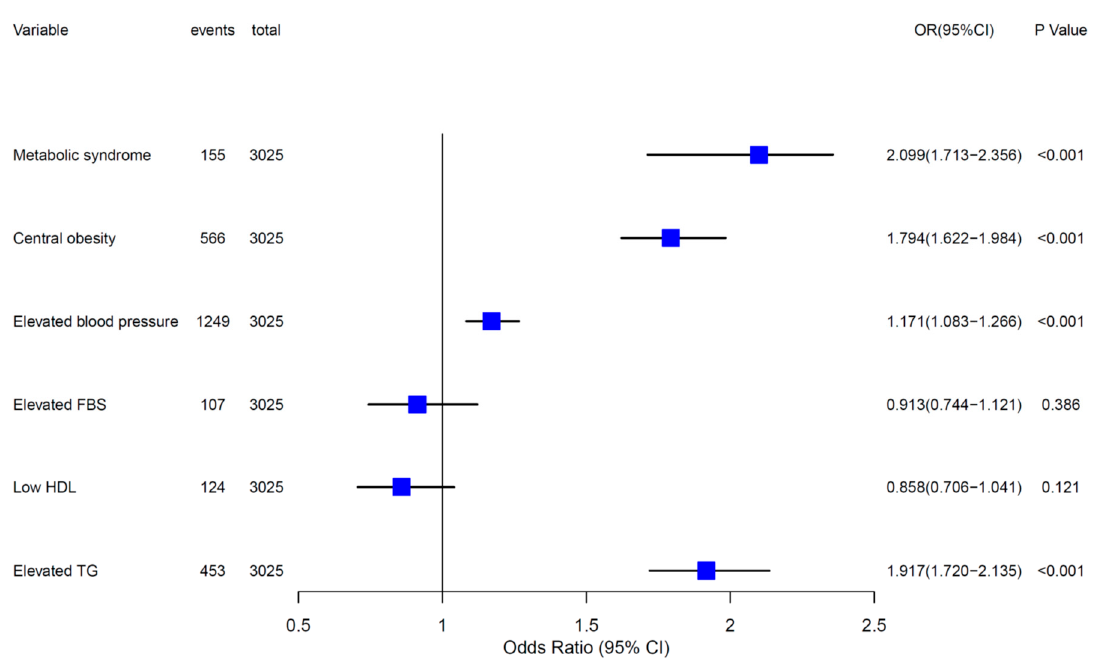
Figure 2. The forest plot of logistic regression analysis results for the associations of serum vitamin A Z scores with MetS and its components. Vitamin A was converted to a z-score by this equation: (Vitamin A − Vitamin A mean )/Vitamin A SD .